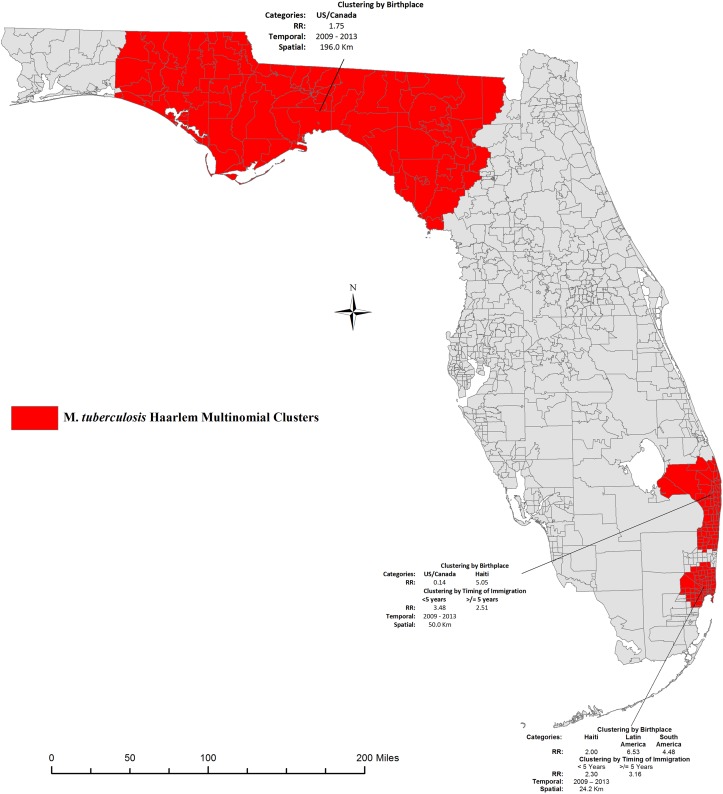
Multinomial space-time cluster of the M. tuberculosis Haarlem in Florida, 2009–2013.Maps show the location of significant multinomial space-time clusters of M. tuberculosis Haarlem in Florida, 2009–2013. Categories refer to case country/region of birth and timing of immigration among foreign-born cases. Relative Risk (RR) estimates indicate whether or not greater than expected numbers occurred in a given category. RR>1 represents a greater than expected number of individuals of certain category inside the spatial cluster compared to outside. Base map layer reprinted from [28] under a CC BY license, with permission from University of Florida GeoPlan Center, original copyright 2012.